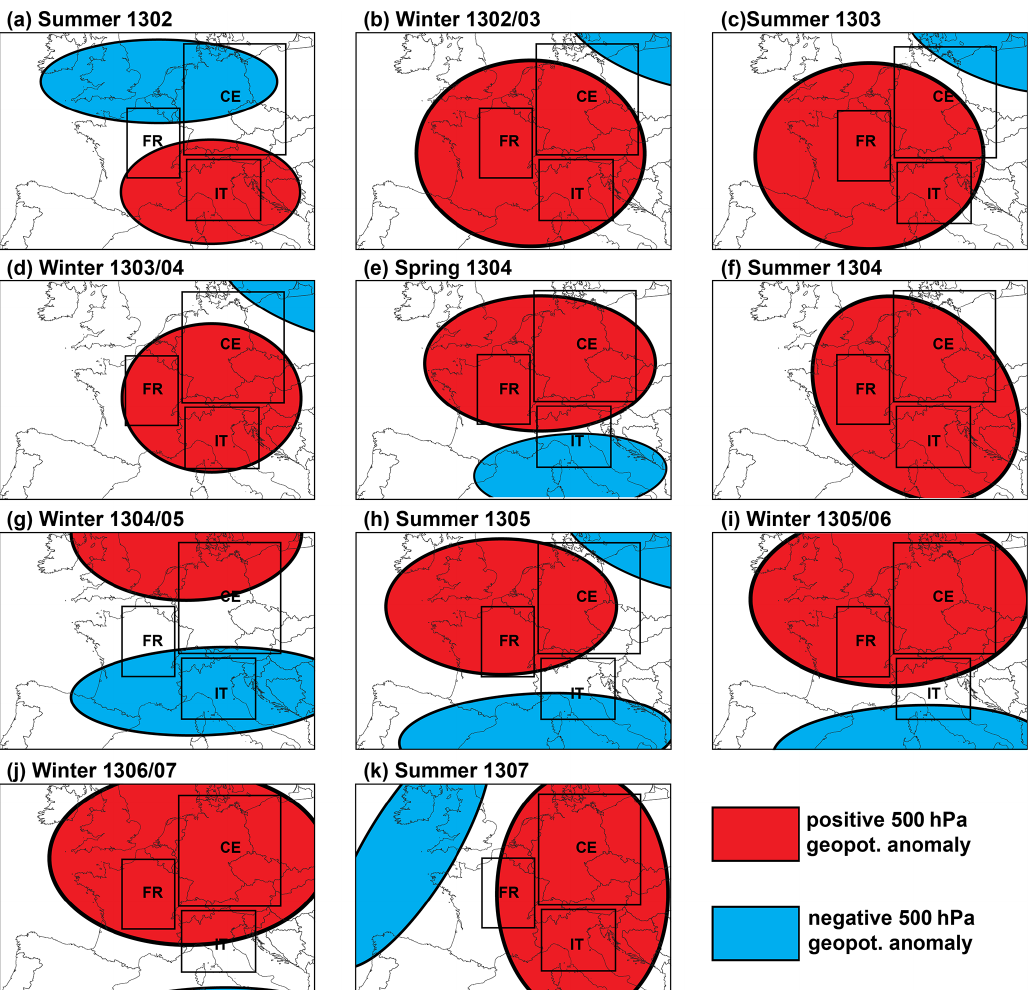
Figure 7. Illustration of the possible constellations of the 500hPa geopotential anomaly that can explain the weather patterns retrieved from the proxy and documentary sources for the years